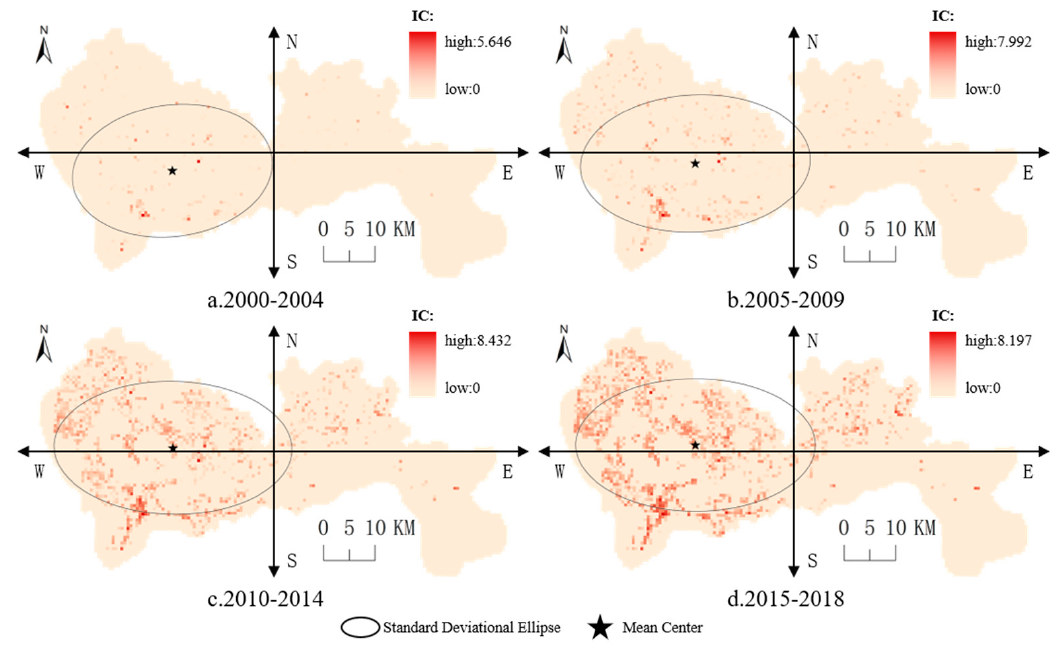
Figure 6. Spatial distribution of the innovation capacity of the secondary industry in Shenzhen.